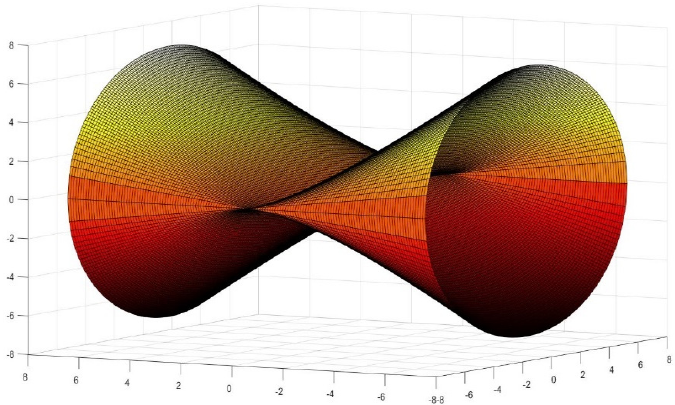
Figure 11. The horizontal part of the body known as Dyosphera. rotated π /2 degrees (Figure 12)